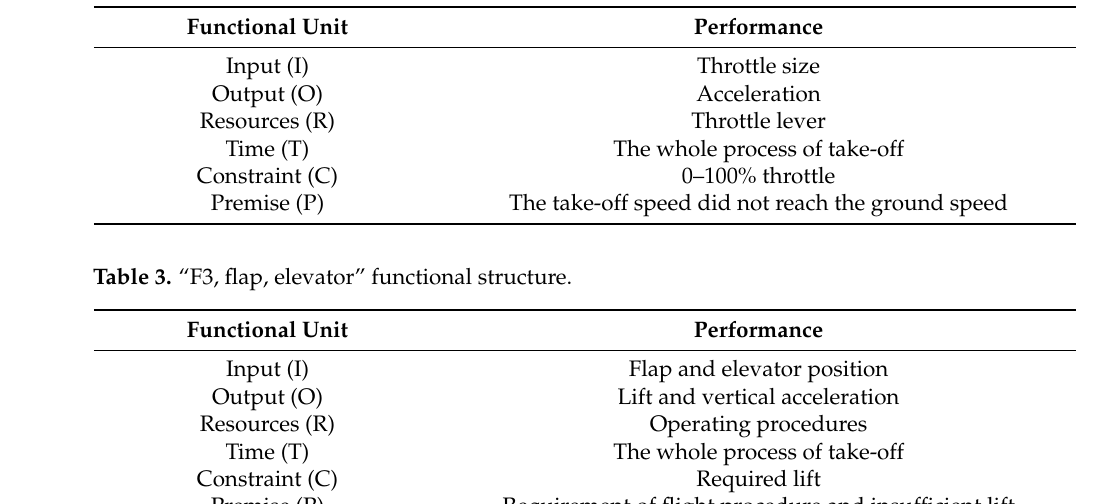
Table 2. The “F1: Throttle” function structure.